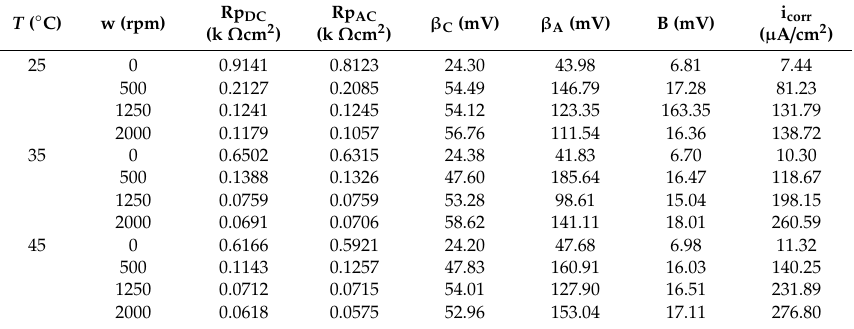
Figure 3. Schematics of the configuration for EIS measurement with ( a ) the 3-electrodes system, ( b ) the 2-electrodes system and ( c ) an EN measurement coupled with the sensors on two panels. Reproduced with permission from ref. [78]. Copyright 2009 Elsevier. Table 1. Electrochemical parameters and corrosion rates of UNS G10200 steel in aerated 3 wt.% NaCl solution at di ff erent temperatures and flow velocities. Reproduced with permission from ref. [79]. Copyright 2008